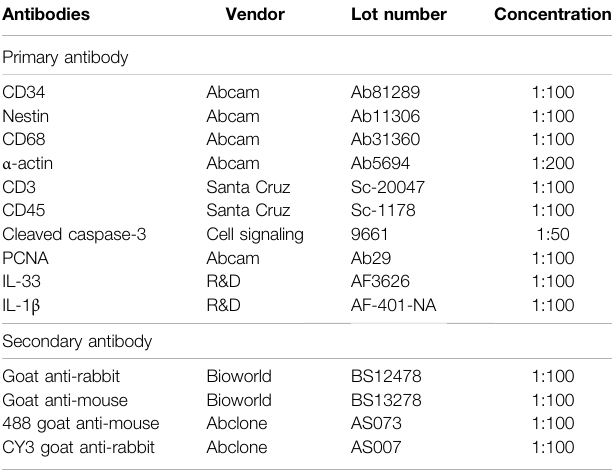
TABLE 1 | Antibodies used in this